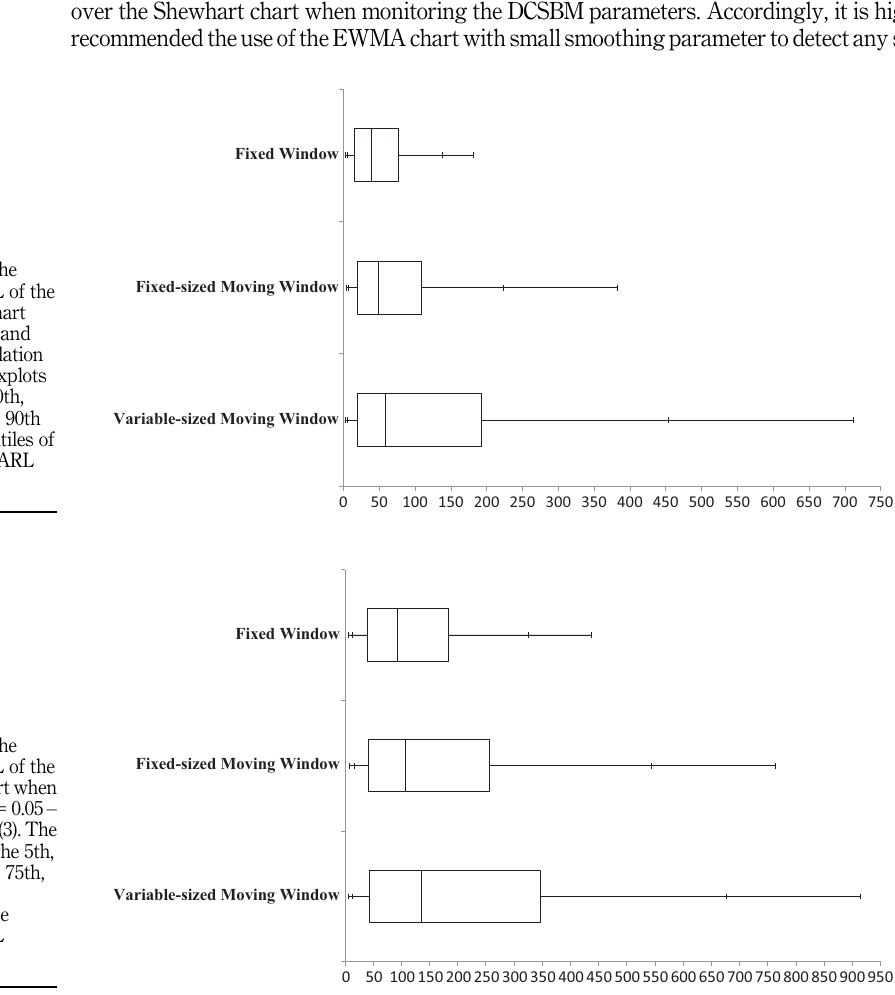
Figure 2. Out-of-control distribution of the conditional ARL of the Shewhart S -chartwhen m 5 500,and e 5 0.05 – simulationcase(3).The boxplots show the